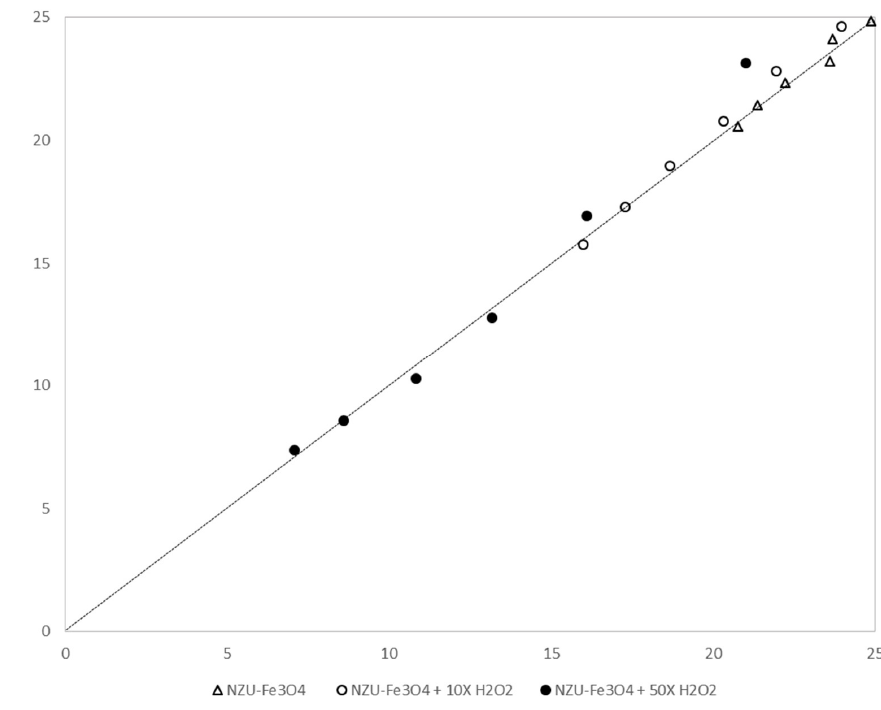
Figure 12. Models results.